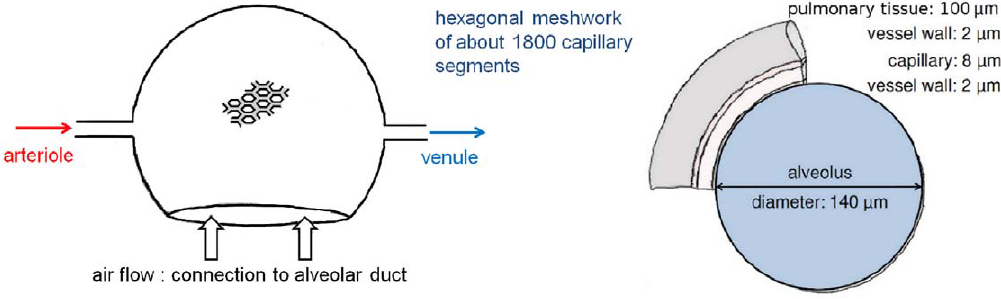
Figure 11. Left. Model domain of the alveolus model for an healthy upscaled node consisting of a spherical shell with an inner diameter of 140 m m and an outer diameter of 364 m m (image modified from Weibel (1991) [33]). Right. Different kind of structures comprised by the model domain of the DCM.